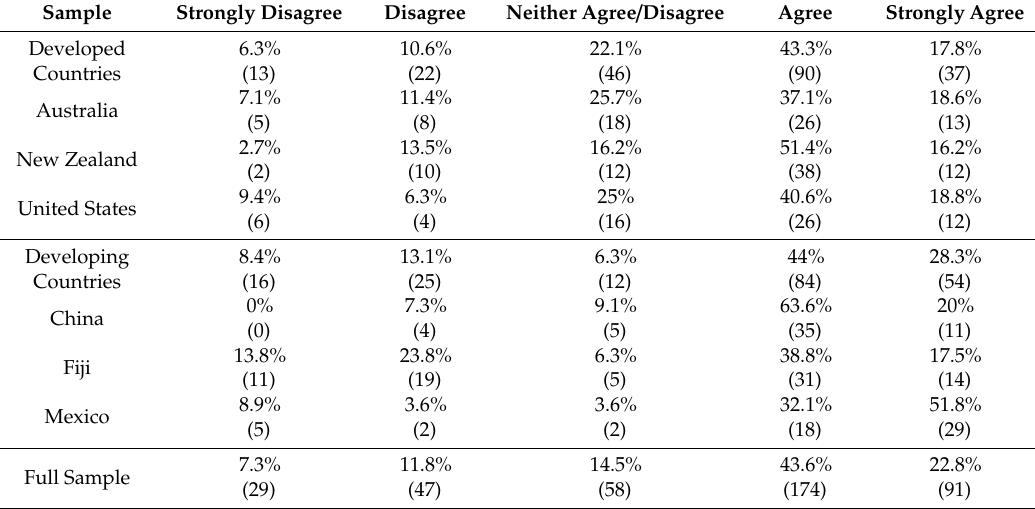
Table 12. Frequency on item: personally, I can help reduce climate change by changing my